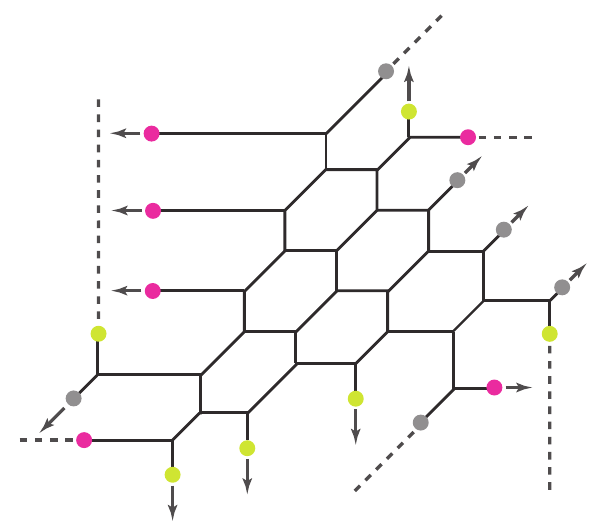
Figure 51 . The Tao web diagram which arises by adding (cid:13)avors at the end nodes of the 5d quiver corresponding to the 5d T 5